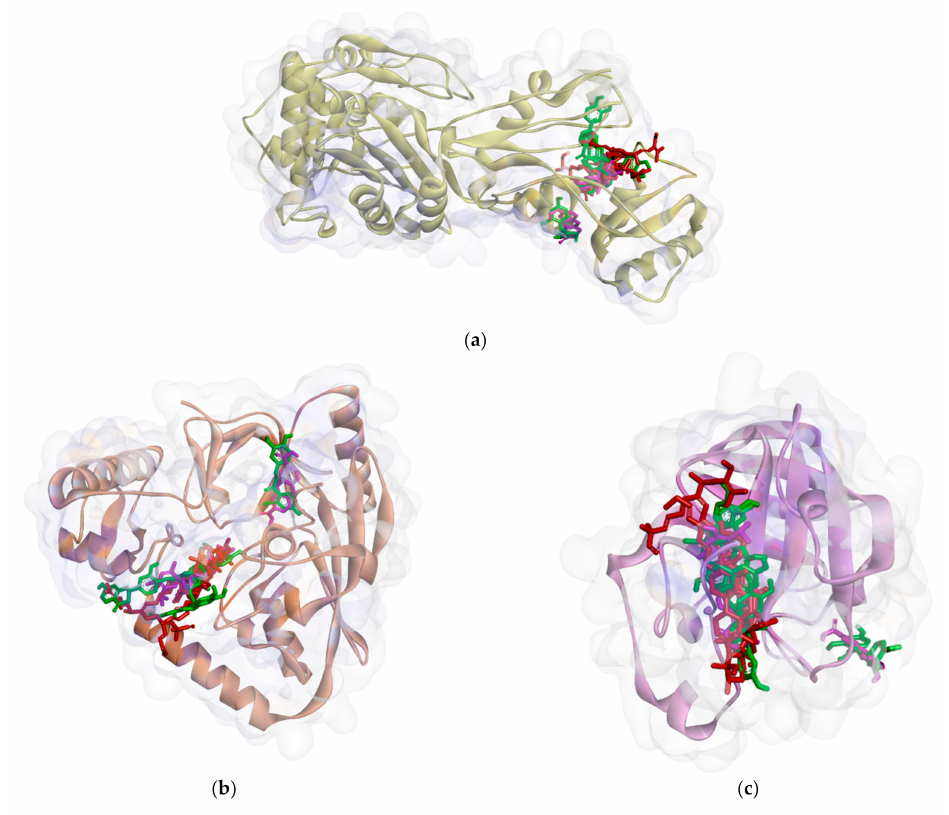
Figure 4. Ligand positions in cell wall protein PBP ( a ), MurB ( b ), and SrtA ( c